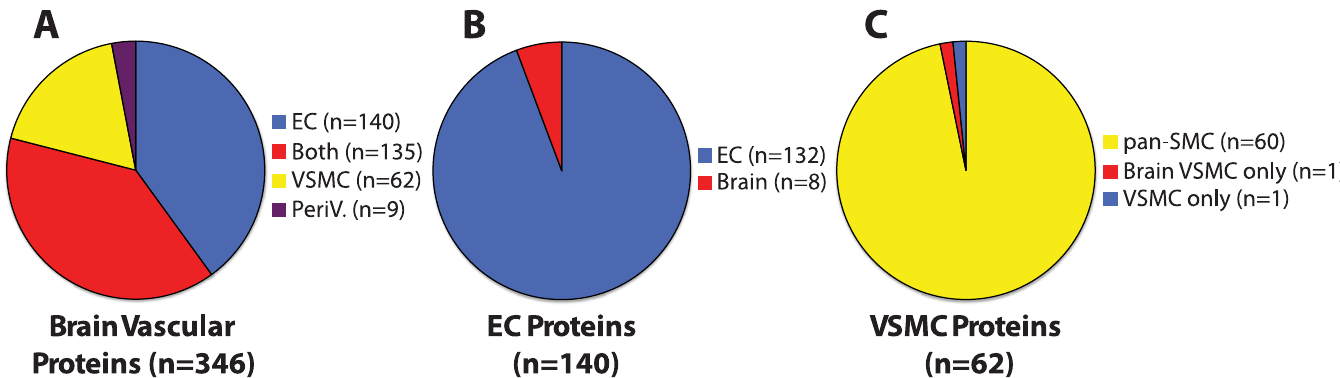
Fig 1. Summary of analysis of human brain vascularproteins curated from the Human Protein Atlas. To graphically demonstrate globalfindings,we present pie charts that summarize data shown in Tables 1–3of this paper. (A) shows distributions of all proteins found primarily in vessels (Tables 1–4).(B) shows tissue distributionsof endothelialcell (EC) proteins(Table 1) and vascular smooth muscle cell (VSMC) proteins (Table 3), respectively. (A) includes perivascular (PeriV) proteins listed in Table 4.